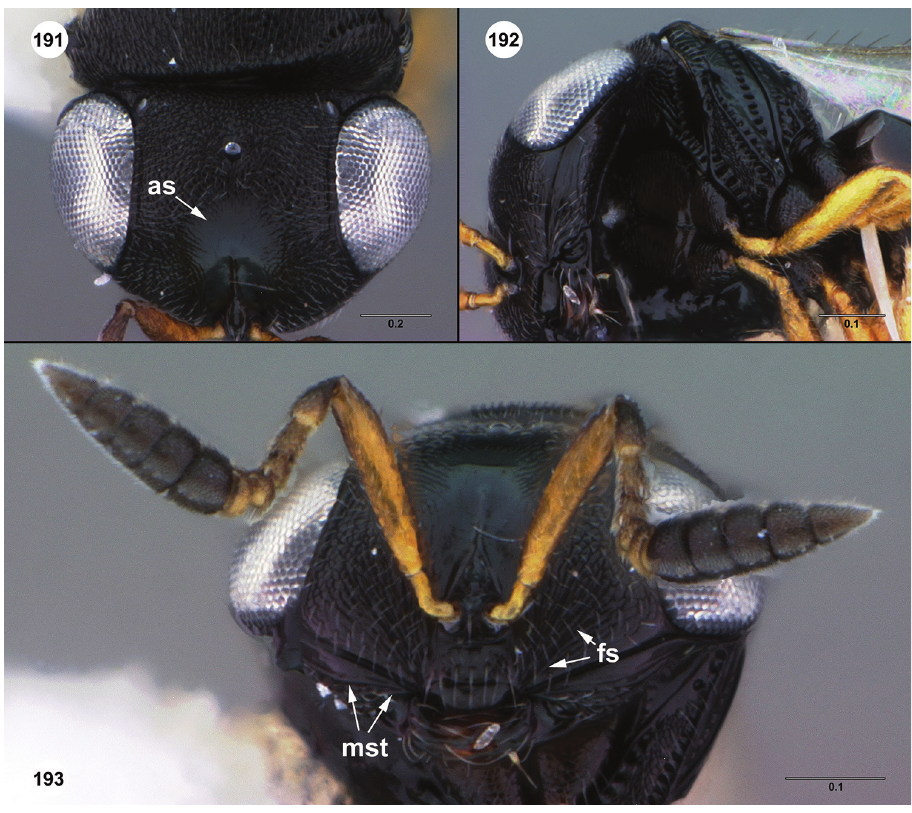
Trissolcus trophonius (Nixon) http://bioguid.osu.edu/xbiod_concepts/3323 Figures 194–198; Morphbank 69 Microphanurus trophonius Nixon, 1938: 123, 127 (original description, keyed); Nixon, 1943: 136, 140 (diagnosis, keyed); Risbec, 1950: 568 (keyed). Trissolcus trophonius (Nixon): Masner, 1965: 128 (type information, generic transfer). Description. Female body length: 0.94–1.08 mm (n=2). Body color: head, meso- soma, and metasoma black. Head. Color of radicle: yellow. Length of radicle: equal to or greater than width of clypeus; less than width of clypeus. Color of A1–A6 in female: yellow, becoming brown distally; basal A1 and distal A2 yellow, elsewhere pale brown. Color of A7–A11 in female: brown. Number of basiconic sensilla on A6: 0. Number of basiconic